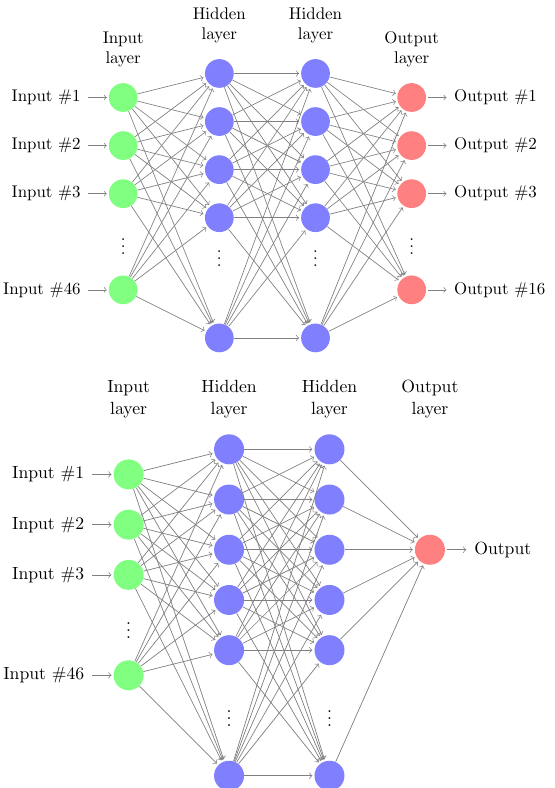
Figure 5. Schematic representation of: ( top ) policy network with 46-dim input (environment states) and 8-dim output (actions); ( bottom ) value network with considered 46-dim input and 1-dim